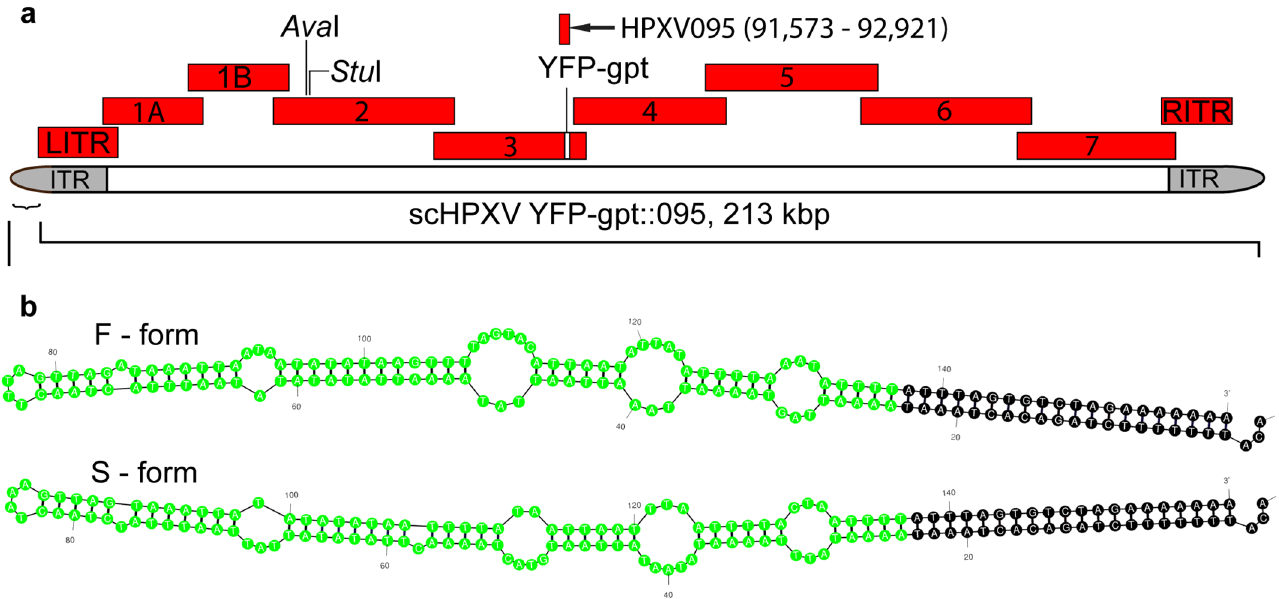
Fig 1. Virus design strategy. ( a ) Clonedsynthetic DNA fragments used to assembleHPXV. Nine different clones were synthesizedspanning all but the first and last 40 bp in GenBank entry DQ792504,each overlappingthe adjacent fragment by ~1 kbp. All of the Aar I and Bsa I restriction sites were eliminated from fragments 1A to 7, inclusive,using silent mutationsand the same strategy was used to add Ava I and Stu I sites in Frag_2. To facilitate virus recovery a gene encoding a YFP-gpt fusion protein was inserted into Frag_3, at the site of the HPXV thymidinekinase locus. An additional HPXV095 fragment spans the thymidinekinase locus and was subsequently used to delete and replace the YFP-gpt marker using homologous recombination. ( b ) Synthetic hairpintelomeres. Becausethe HPXV genomewas not sequencedto the ends, we substituted two hairpin sequences based uponthose reportedfor VACV strain WR (green coloured nucleotides). These are called“fast” and “slow” forms basedupon their electrophoretic properties.The nucleotidescolouredin black come from the HPXV genomesequenceand provide an element essentialfor telomereresolution.